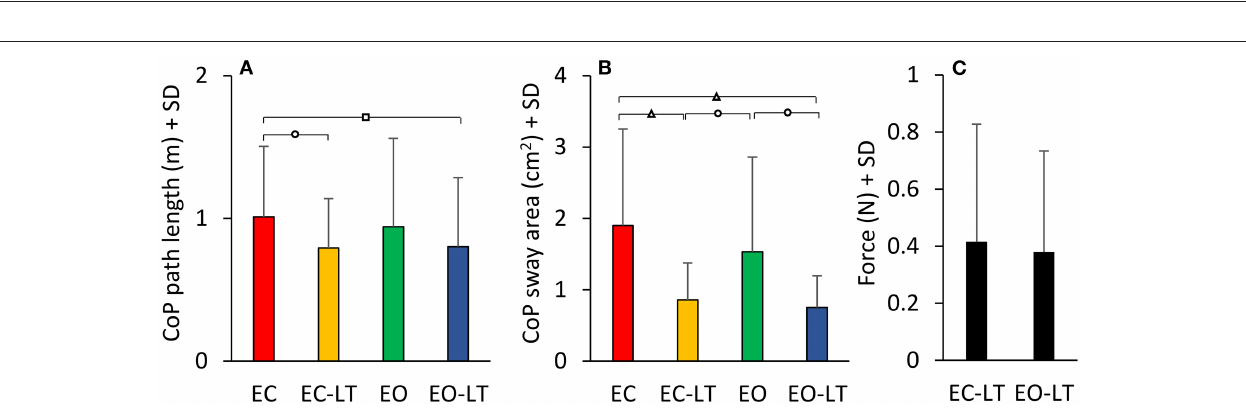
FIGURE 12 | amplitudes of the spectrum. The median frequency of the entire spectrum was not much different across conditions (C,D) . However, the mean level was larger in AP than ML (both EC and EO), and much larger without touch (E,F) . Overall, median frequencies were about half, and the mean level was about half to a quarter of those with foam (compare to Figure 5 ). The changes with respect to EC of the distinct frequency windows are shown in the radar plots (G,H) for both ML and AP directions. Compared to the foam conditions (see Figure 8 ), the mean levels are less than half. Distinct symbols indicate significant differences ( 2 p < 0.05; ◦ p < 0.01; 1 p < 0.001).